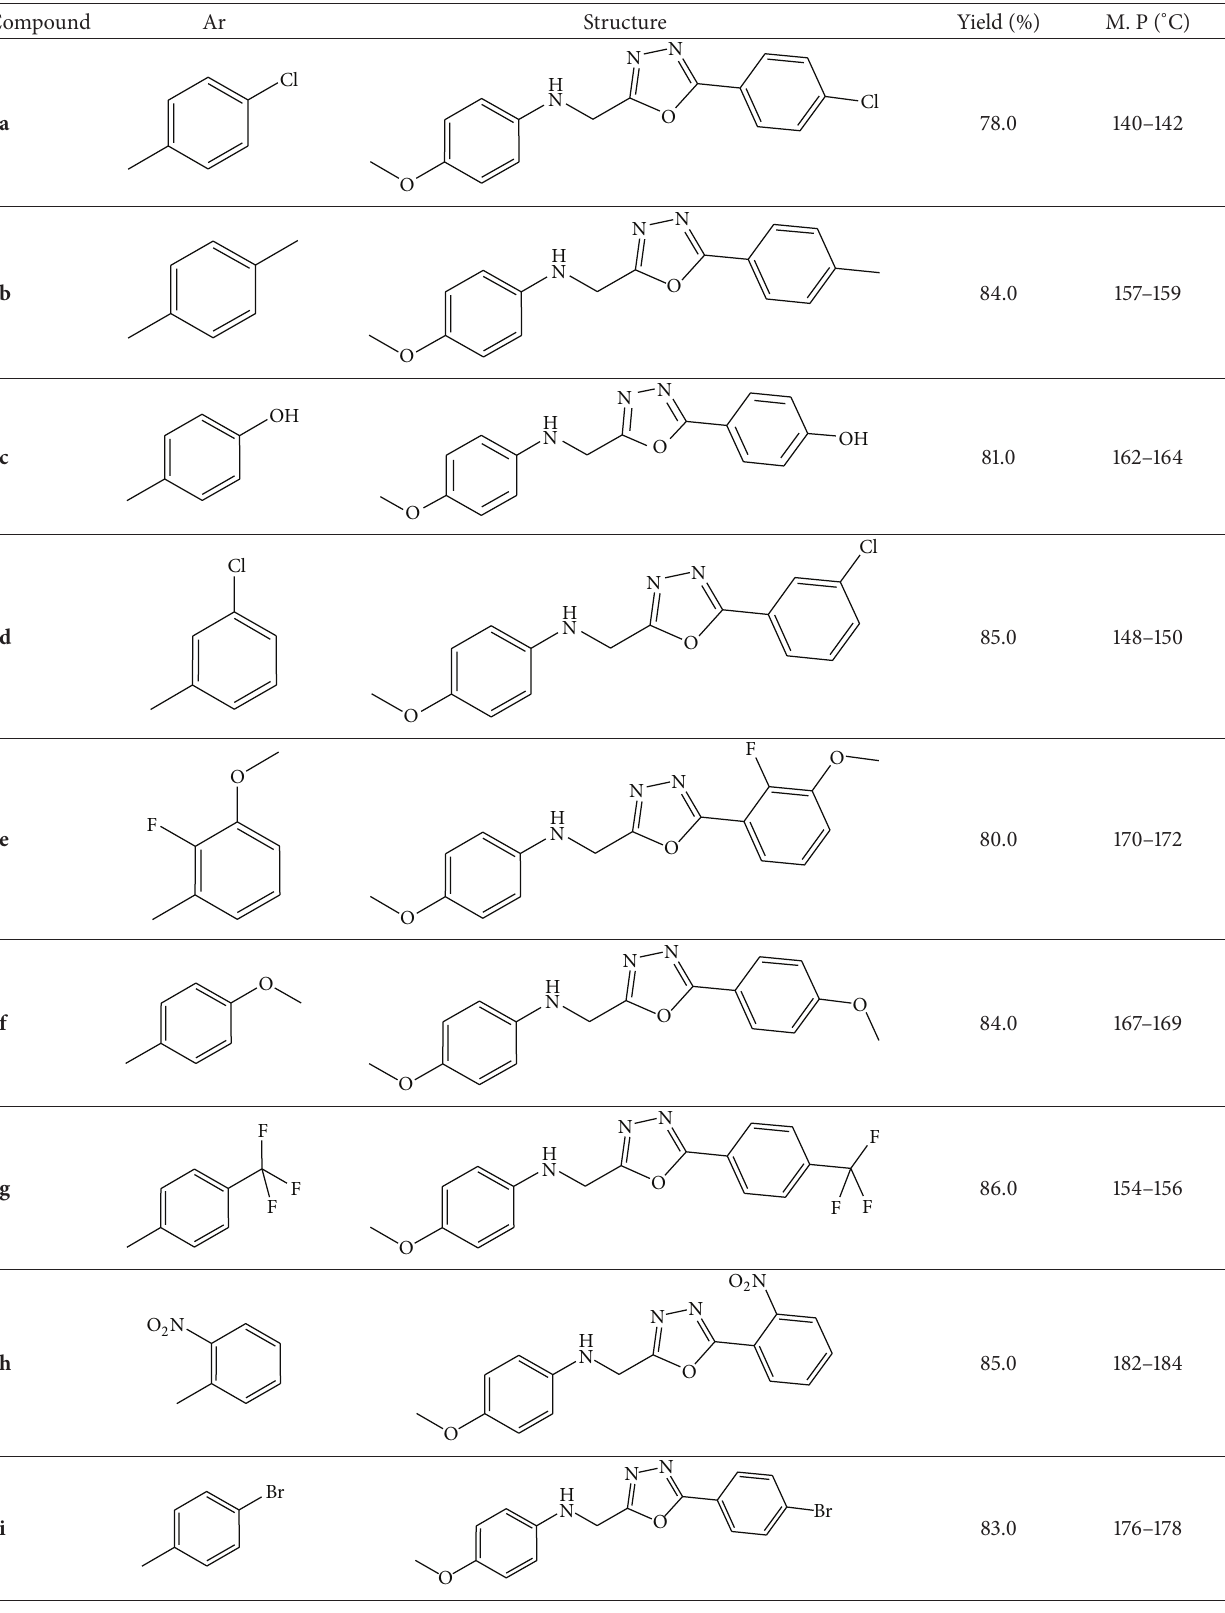
Table 1: Chemical structure and physical data of 2,5-disubstituted-1,3,4-oxadiazoles 4(a–i) .